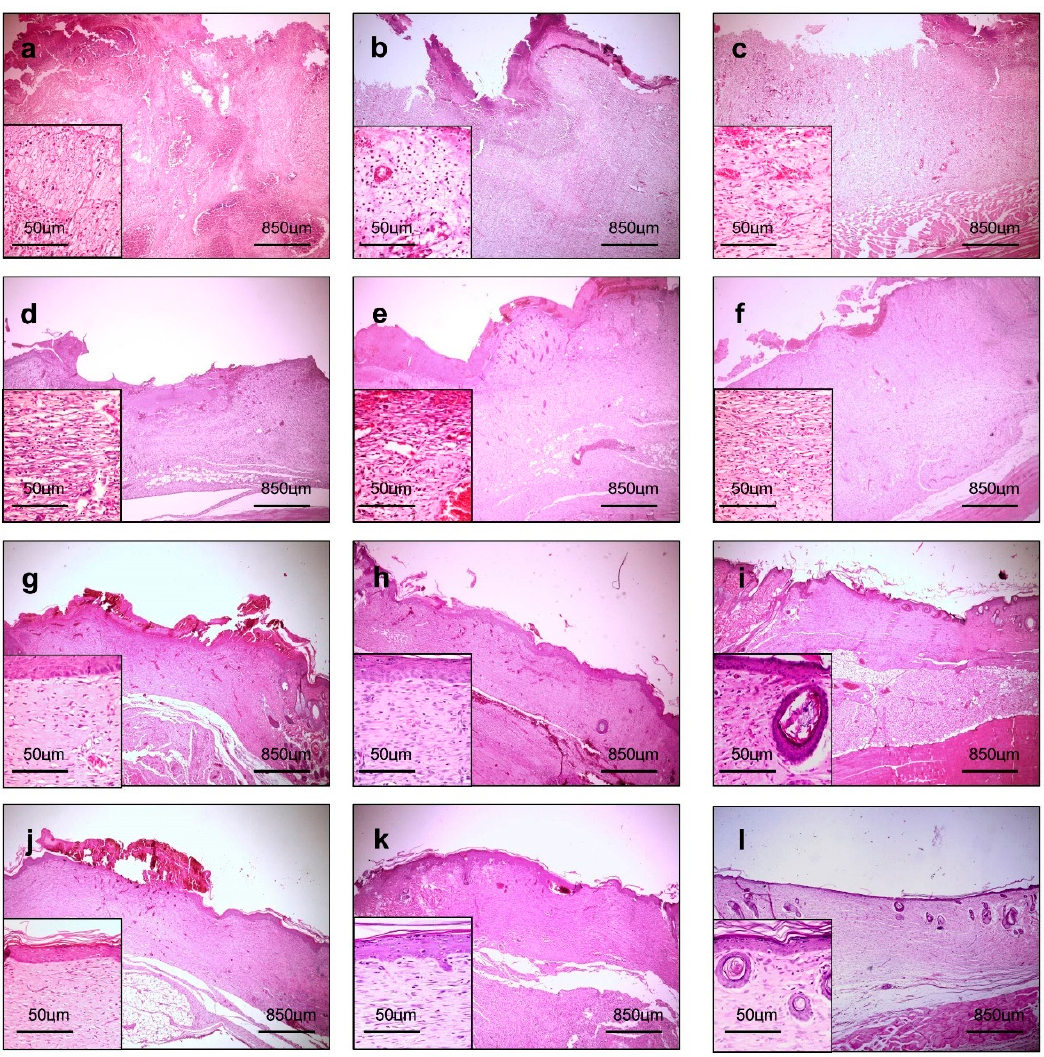
Figure 6. Histological sections of the groups (wounded areas) of the wound-healing biological assay over a course of time. An intense inflammatory response and edema are observed in the CTR ( a ) and GEL ( b ), while immature granulation tissue is observed in GELPG at day 3 ( c ). Well-vascularized granulation tissue is observed in the CTR ( d ) and GEL ( e ) at day 7, while fibrous connective tissue was formed in GELPG ( f ). Primary fibrous scars can be seen in all of the groups at day 14 ( g – i ), though hair follicles already began forming in GELPG (I). Dense fibrous connective tissue is seen in all the groups at day 21 ( j – l ), with multiple hair follicles observed in GELPG ( l ) (HE, 40 / 400 × magnification).